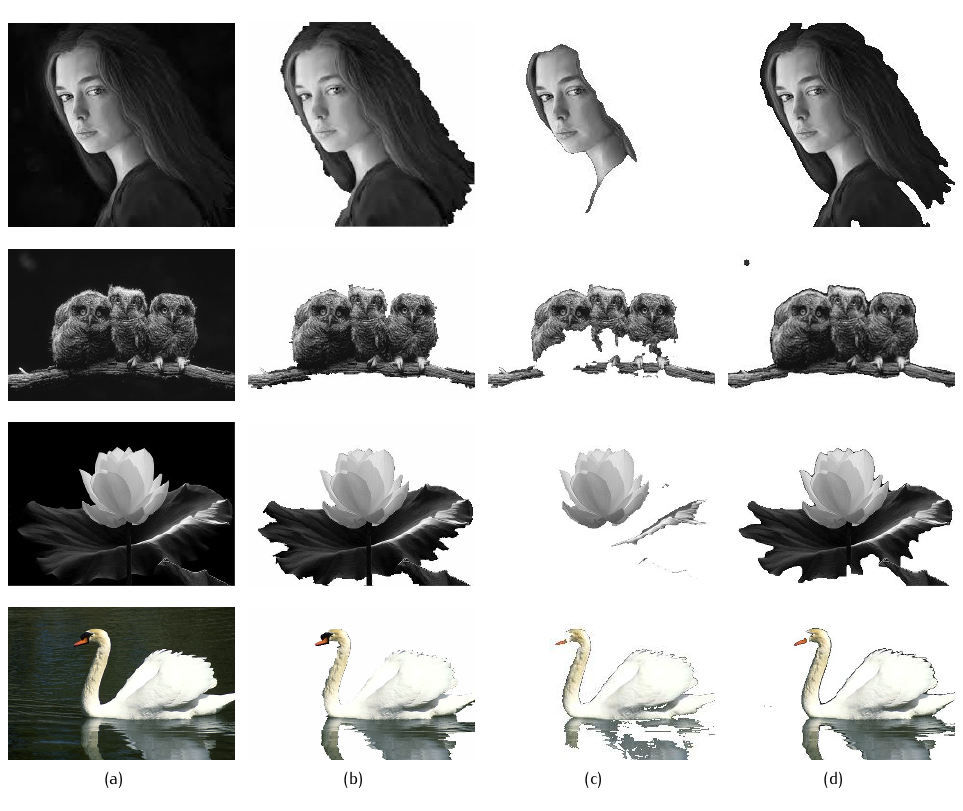
Figure 4. Demonstration of different unsupervised segmentation approaches on low key images. (a) 4 typical low key images which are chosen from Internet and BSDS500. (b) Manual segmentation results. (c) Segmentation results yielded by CV model [13]. (d) Segmentation results produced by our proposed algorithm.